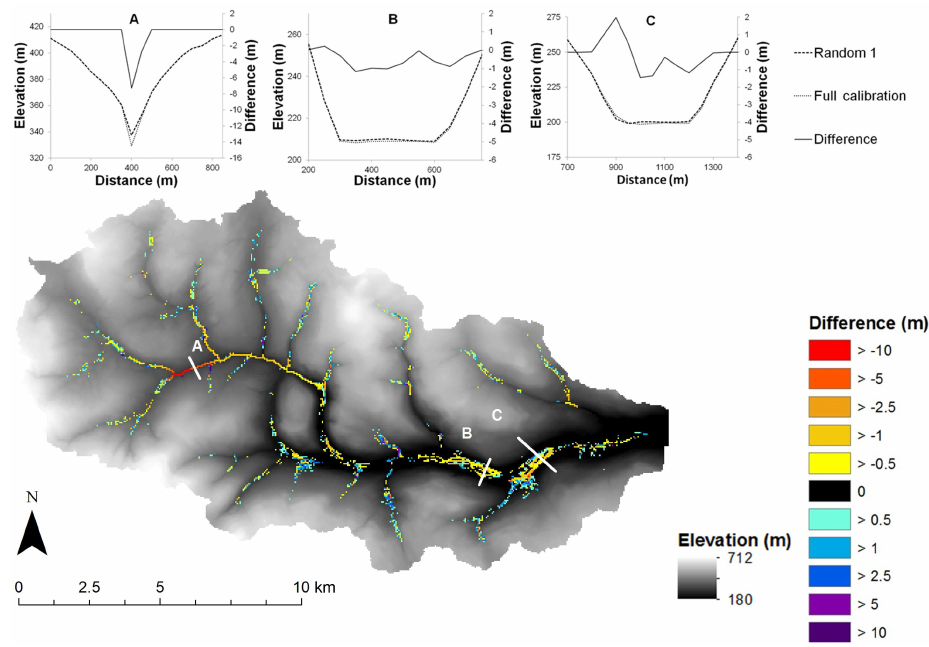
Figure 8. DEM of difference for the adjusted temporal and spatial resolution comparison. The differences shown are elevations from the Figure 9. Relationship between the total rainfall and mean elevation for each 5 km pixel within the Complete Swale basin. 24h × Lump (2.2 factor) simulation minus the elevations from the 0.25h × 5km. Yellows to reds indicate where the first (24h × Lump 2.2) simulation has eroded more and deposited less than the second (0.25h × 5km) simulation. Blues indicate more deposition and less erosion.